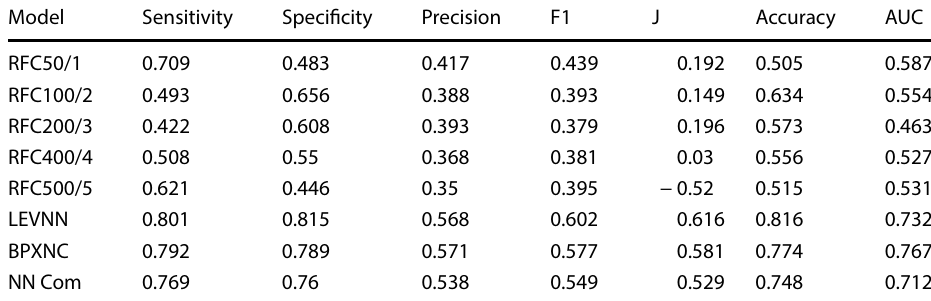
Table 13 Classification performance (testing